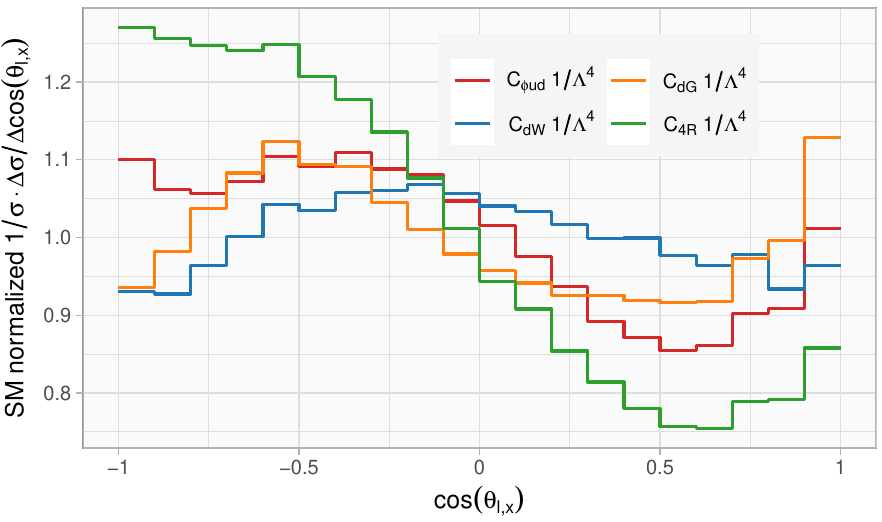
Figure 23. To itself and to the SM normalized SMEFT contributions to the cos (cid:18) l;x distribution at NLO in QCD . Results are presented for Q 33 operator Q 4 R .